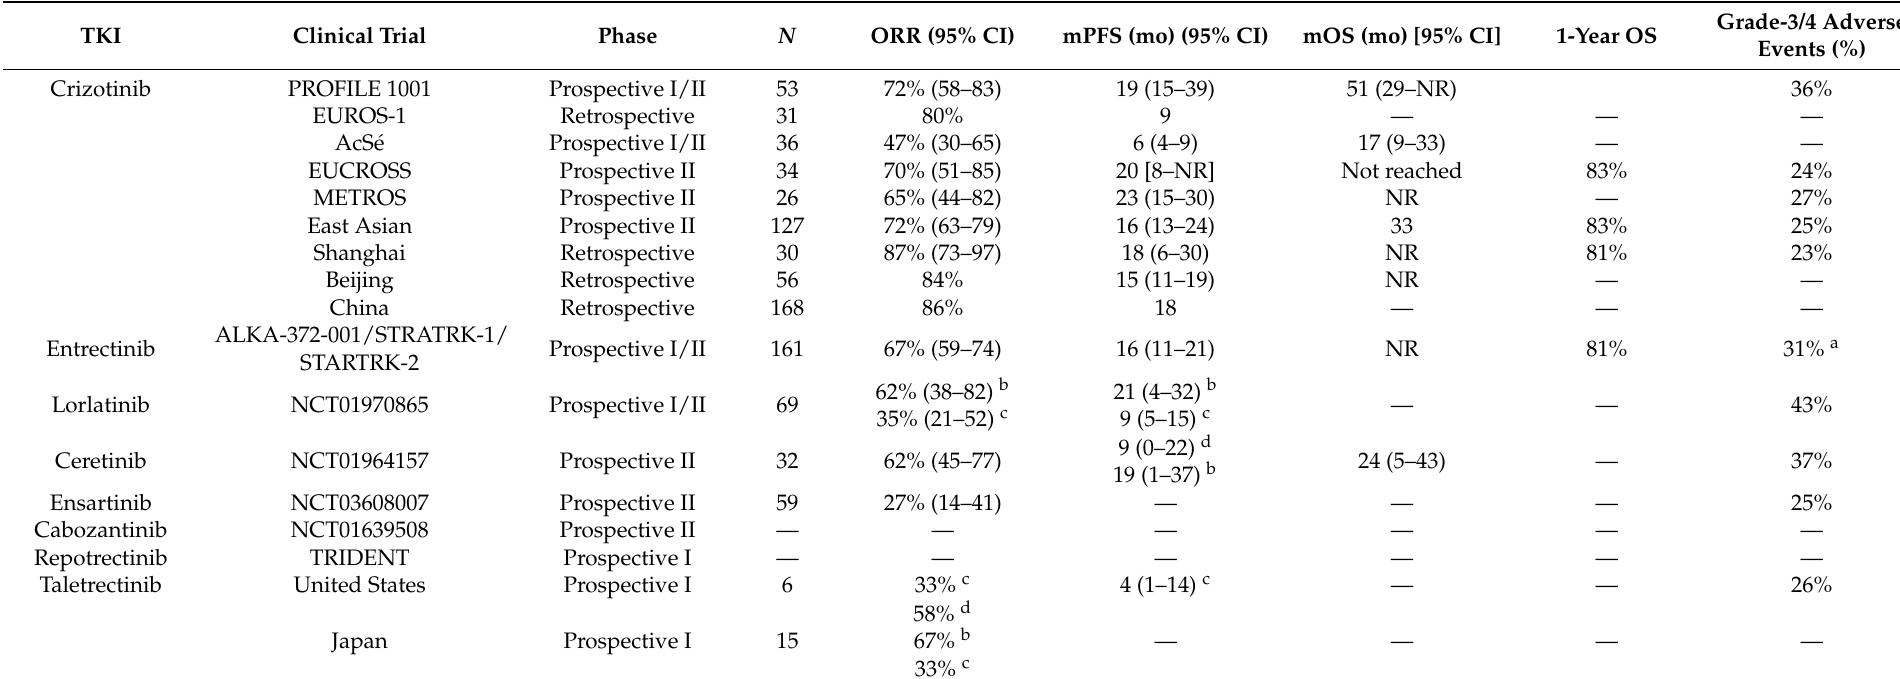
Table 2. Summary of clinical trials on tyrosine-kinase inhibitors (TKIs) targeting ROS-1 in patients with ROS-1 -positive non-small-cell lung cancers.